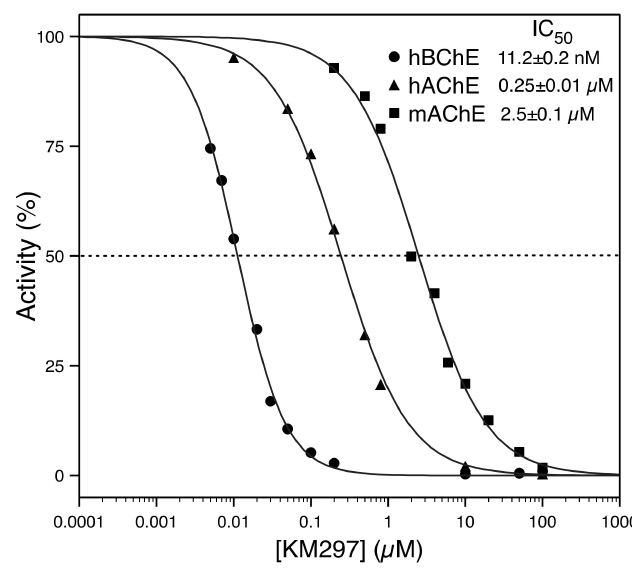
Figure 5. In vitro IC 50 determination of KM297 HCl for hAChE, mAChE, and